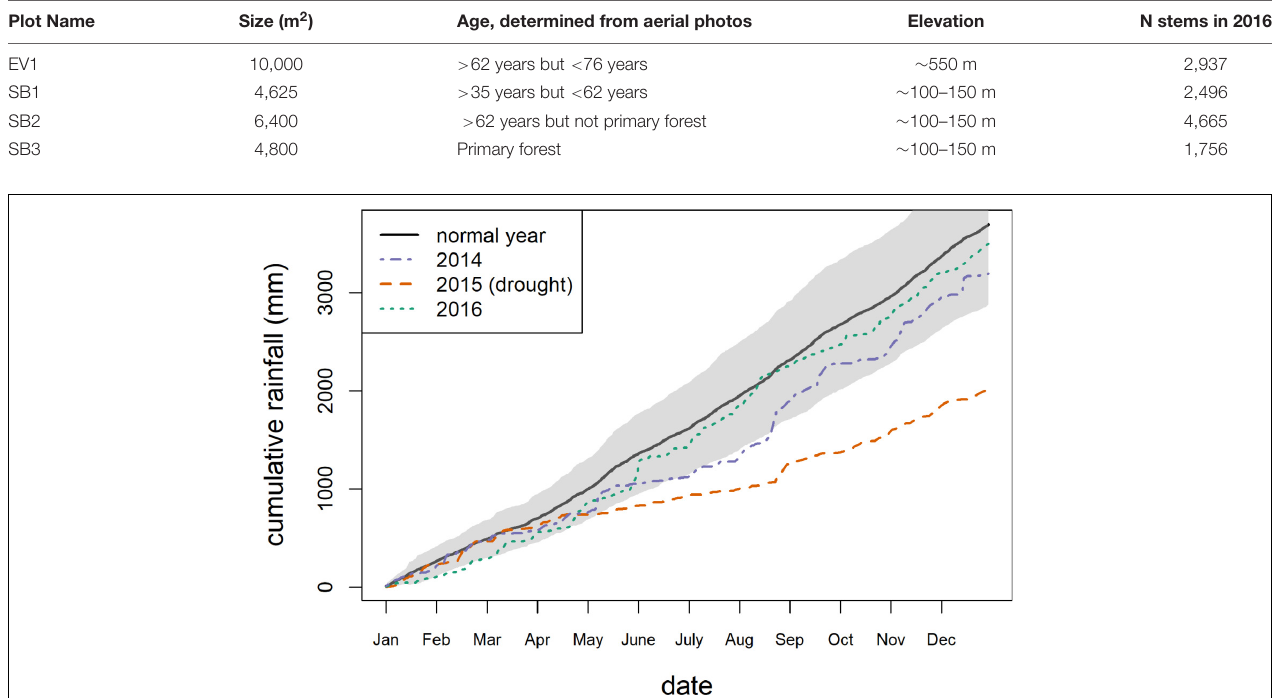
was calculated such that positive curvature indicates valley- like microtopography and negative curvature indicates ridge-like microtopography. We used the georeferenced stem locations from the plot data to extract slope and curvature at the stem location for each tree. Slope and curvature in this dataset were not correlated ( r = − 0.004). Though the mean slope and curvature differ across plots, plots encompass large, overlapping ranges of values for slope and curvature ( Supplementary Figure S2